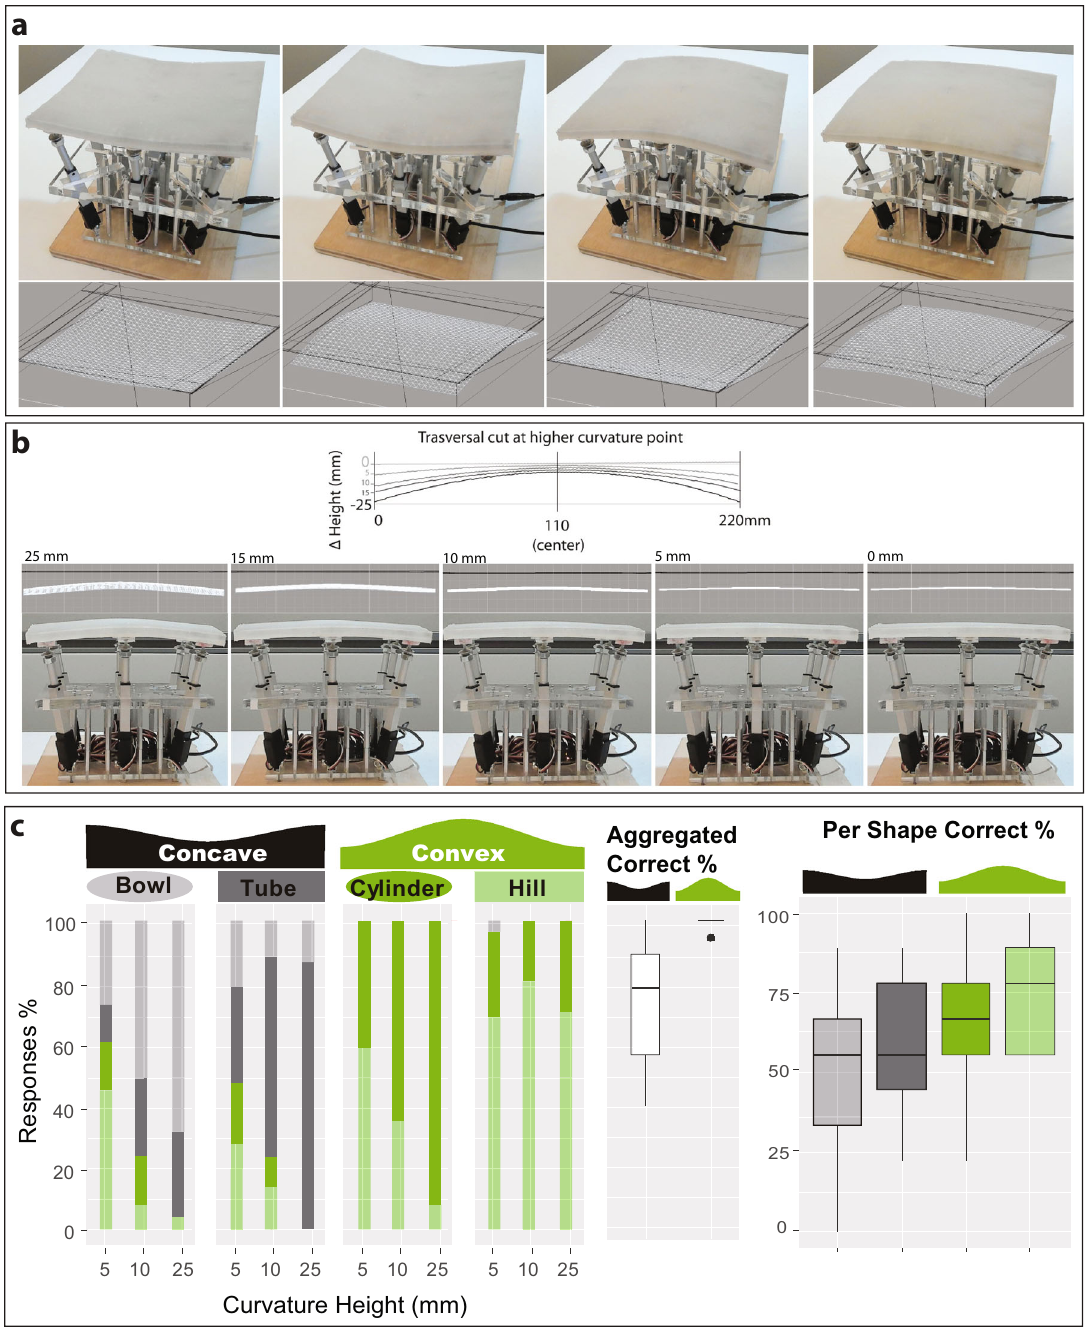
Fig. 6 Four shapes and heights tested. a Rendering at 25 mm of a concave bowl, concave cylinder, convex tube, and a convex hill. b Different heights tested. Note that the 5 mm curvature is almost fl at. In the graph, the curvatures are shown as a quadratic function of the meshes measured by the Kinect depth sensor. The Y dislocation is shown only to help visualize the curvatures that go from less to more hilly. The maximum depth height ( − 25 mm) was a known good, and 0 mm was fl at. c Classi fi cation responses of participants ( n = 17 with 36 comparison trials) when presented with a particular shape in different curvatures. The boxplot on the right shows the overall ability of the shape display to render concave or convex shapes. For the boxplot: the center line represents the median; box limits represent upper and lower quartiles; whiskers the 1.5× interquartile range; and individual points are